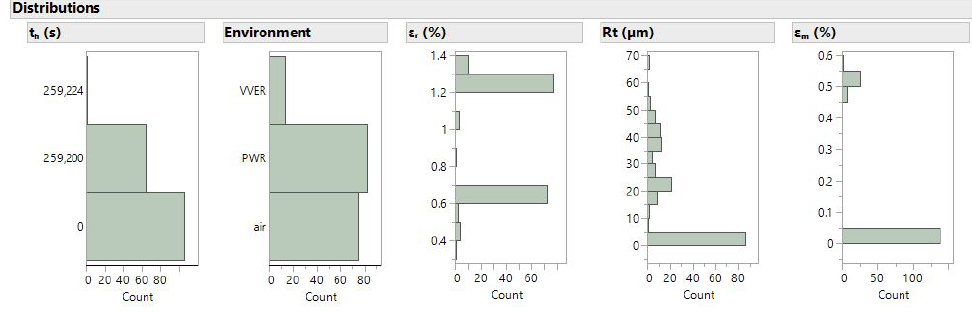
Figure 3. Distribution of the factors in the main